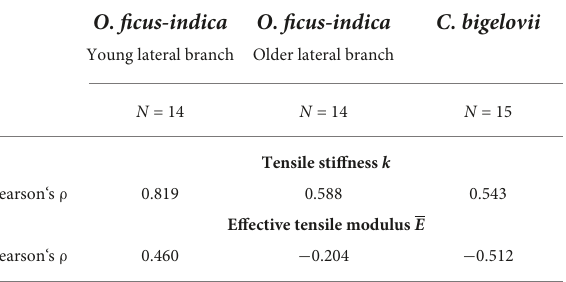
TABLE 1 Correlation results of the elastic behavior variables under tensile loading with the lateral branch mass for all the three analyzed